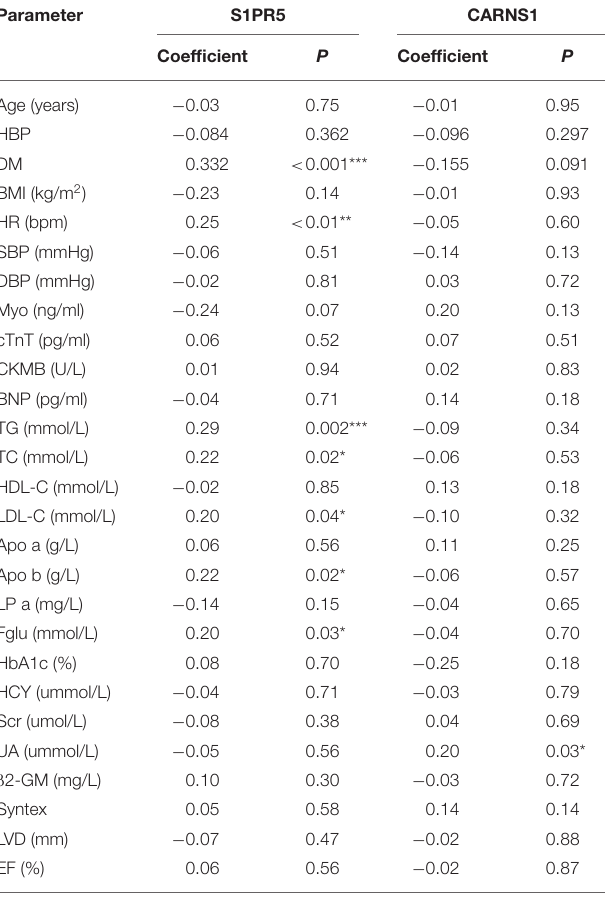
TABLE 2 | Correlation between baseline characteristic and mRNAs level in CHD patients. Parameter S1PR5 CARNS1 Coefficient P Coefficient P